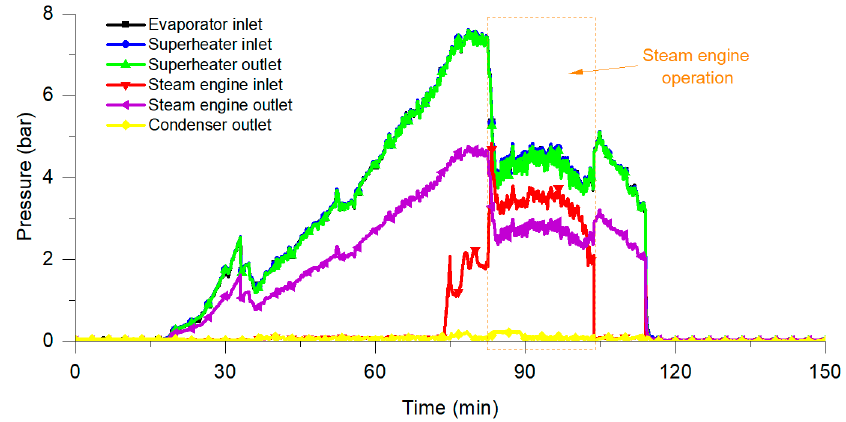
Figure 14. Steam pressure at the outlet from superheater and inlet to the steam engine and the steam flow in the steam bus.